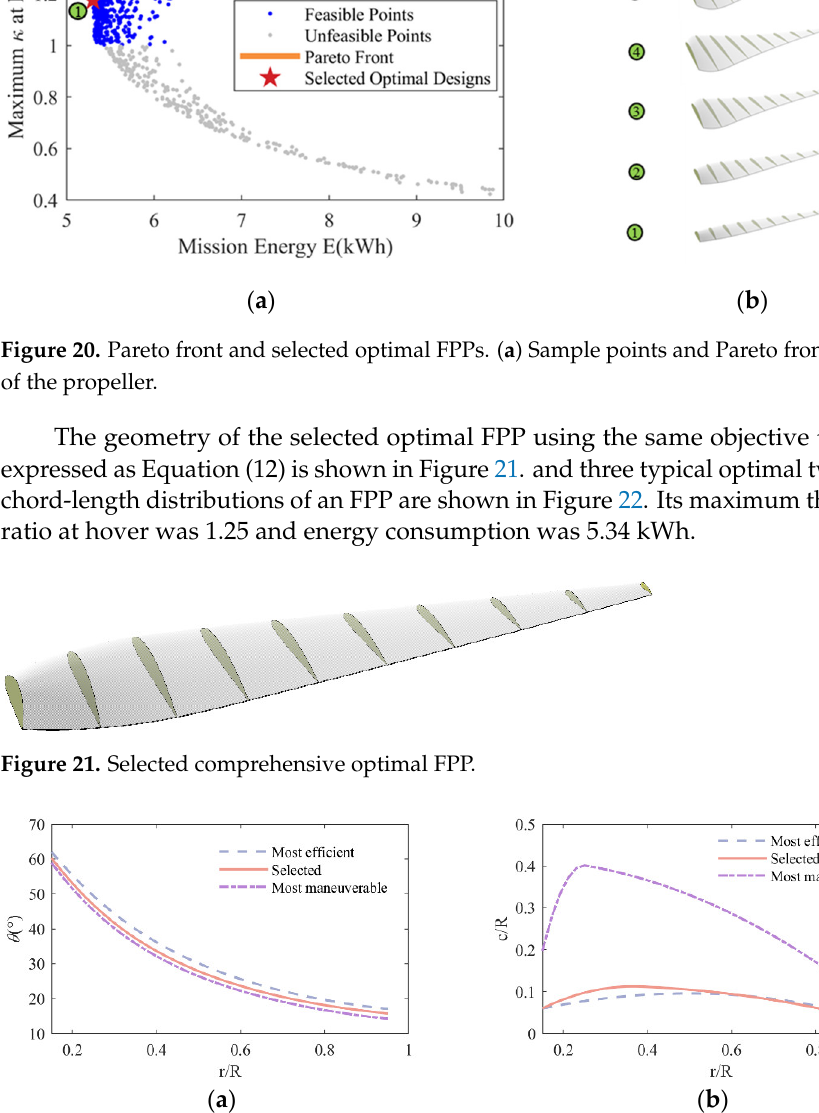
Figure 22. Twist angle and chord-length distribution of a comprehensive optimal FPP. ( a ) Twist angle distribution; ( b ) chord-length distribution.